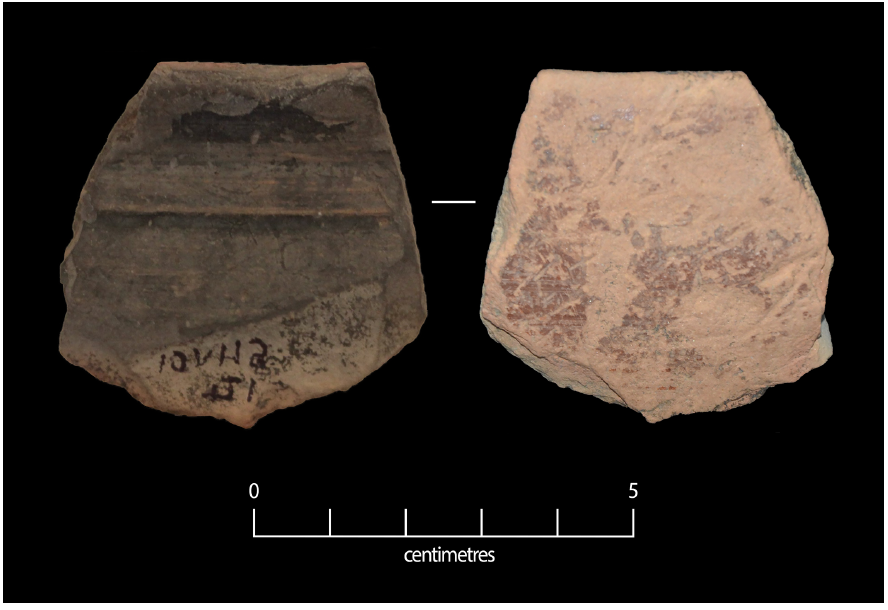
Figure 29: External and internal surface of a Class 9 variant 2